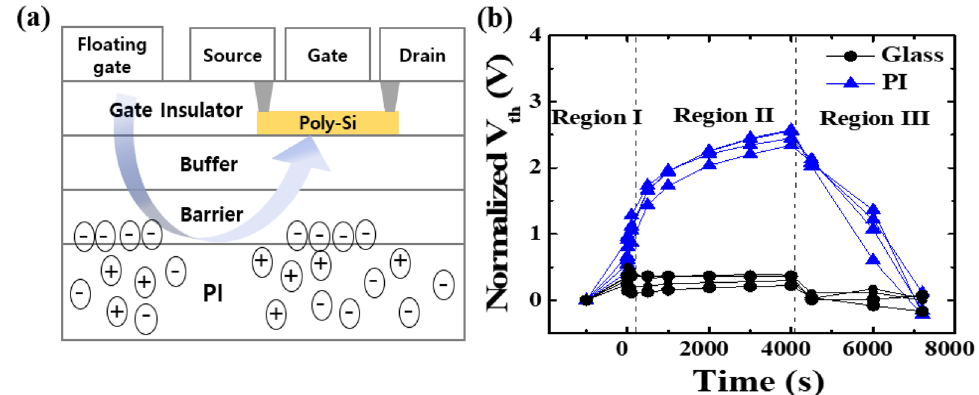
Figure 2. ( a ) Schematic of 4-pad characterization (floating gate, source, gate and drain) and ( b ) normalized V th behaviors of P-type LTPS TFTs fabricated on the on glass (black filled circle) and PI (blue filled triangle)